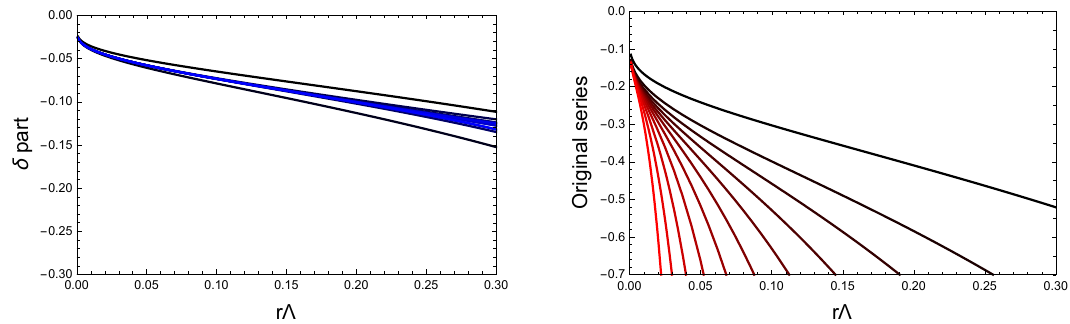
Figure 8 . Perturbative series of the (cid:14) part for the dimensionless potential (left). This is compared to the original series containing renormalons (right). Deeper blue (red) line corresponds to higher order result. The highest order is O ( (cid:11) 11 ). s